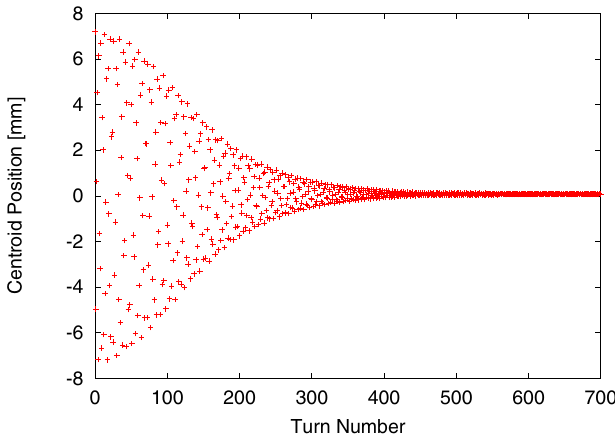
FIG. 1. (Color) Horizontal position of the centroid of the beam versus turn number for the SPS with extraction sextupoles